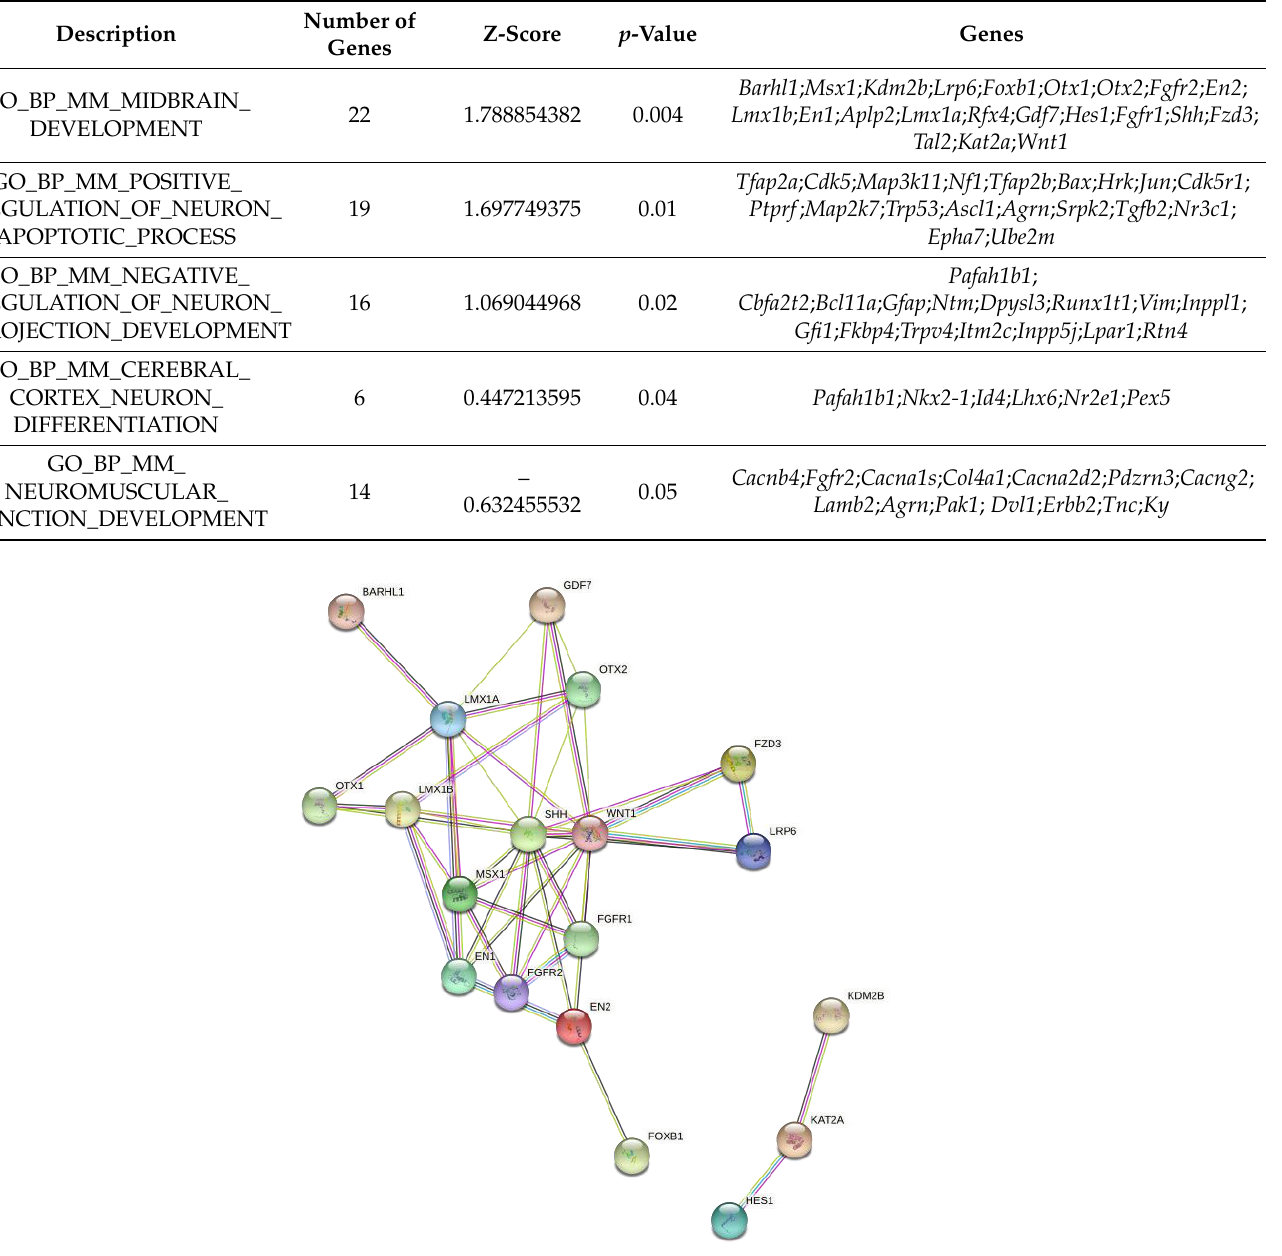
Table 2. GO pathways, and the corresponding genes involved in these pathways.